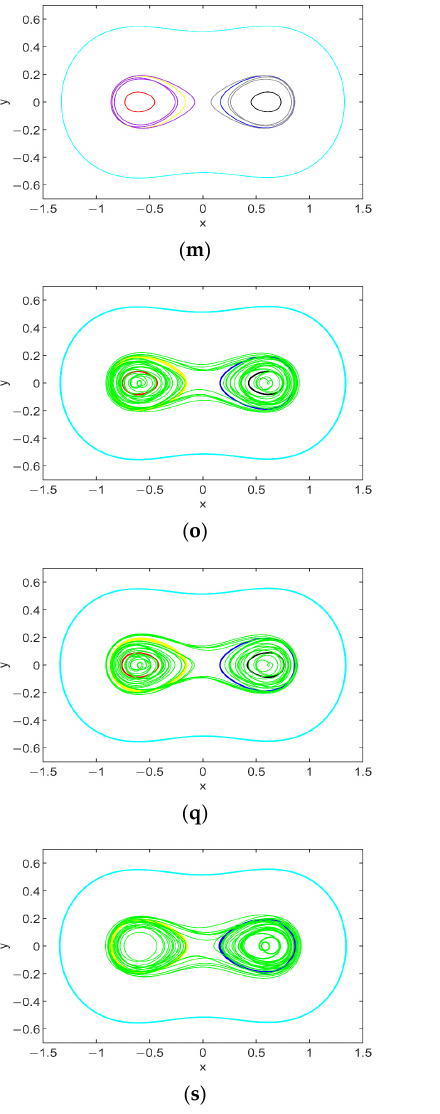
Figure 8. Evolution of attractors and their BA with an increase in f 0 for ω = 0.5: ( a ) phase map of the attractors for f 0 = 0; ( b ) basins of attraction for f 0 = 0; ( c ) phase map of the attractors for f 0 = 0.003; ( d ) basins of attraction for f 0 = 0.003; ( e ) phase map of the attractors for f 0 = 0.004; ( f ) basins of attraction for f 0 = 0.004; ( g ) phase map of the attractors for f 0 = 0.009; ( h ) basins of attraction for f 0 = 0.009; ( i ) phase map of the attractors for f 0 = 0.011; ( j ) basins of attraction for f 0 = 0.011; ( k ) phase map of the attractors for f 0 = 0.0128; ( l ) basins of attraction for f 0 = 0.0128; ( m ) phase map of the attractors for f 0 = 0.013; ( n ) basins of attraction for f 0 = 0.013; ( o ) phase map of the attractors for f 0 = 0.014; ( p ) basins of attraction for f 0 = 0.014; ( q ) phase map of the attractors for f 0 = 0.0143; ( r ) basins of attraction for f 0 = 0.0143; ( s ) phase map of the attractors for f 0 = 0.015; and ( t ) basins of attraction for f 0 =